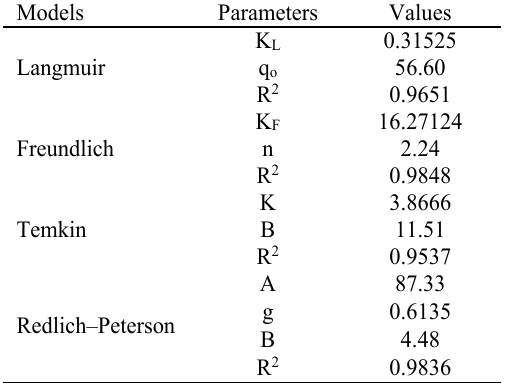
= 50-160 mg L -1 , o